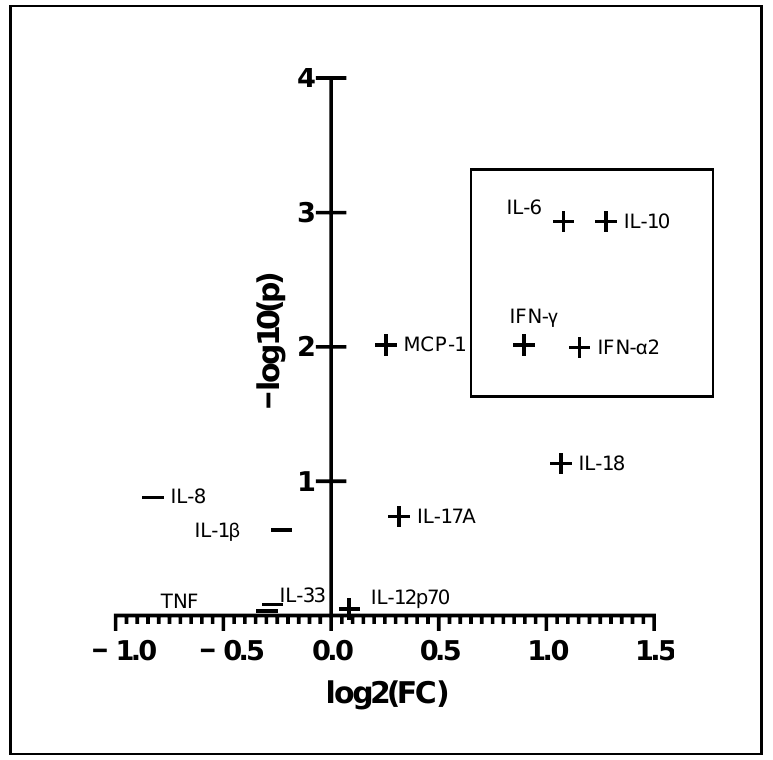
Figure 5. Volcano plot showing the univariate analysis of cytokines in patients who were admitted to the hospital against patients who stayed confined at home. The black rectangle on the right encloses the cytokines that showed significance (FDR p < 0.05) and a fold change of more than